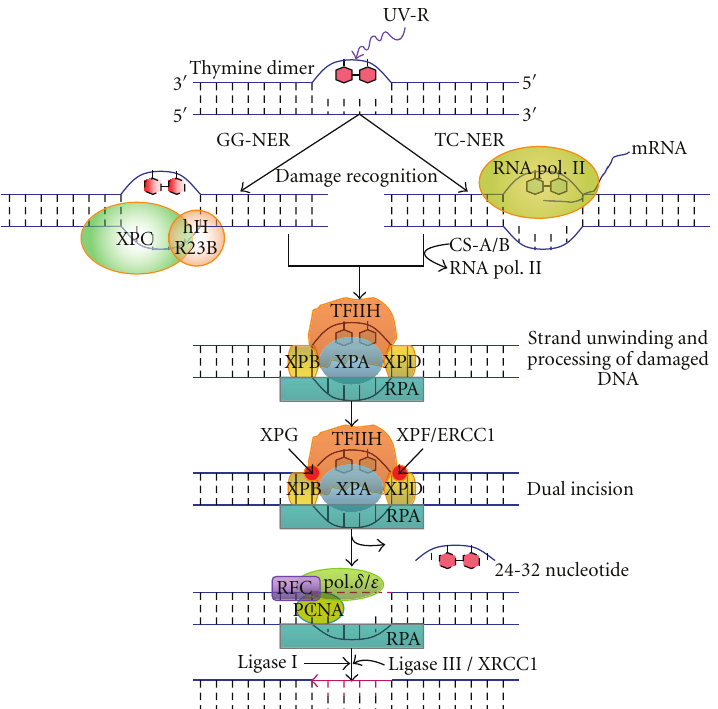
Figure 11: Molecular mechanisms of global genome nucleotide excision repair (GG-NER) and transcriptional coupled nucleotide excision repair (TC-NER) in mammals. For details see the